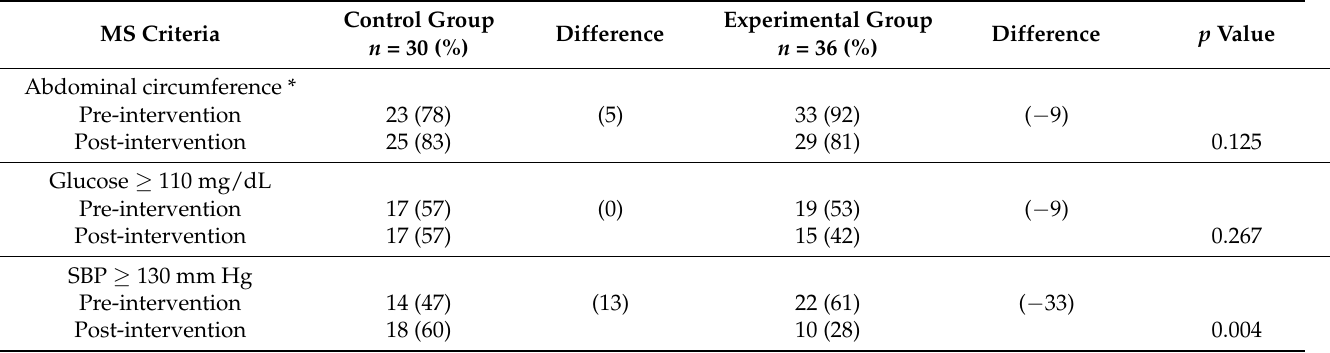
Table 6. Frequency of metabolic syndrome criteria pre- and post-intervention by